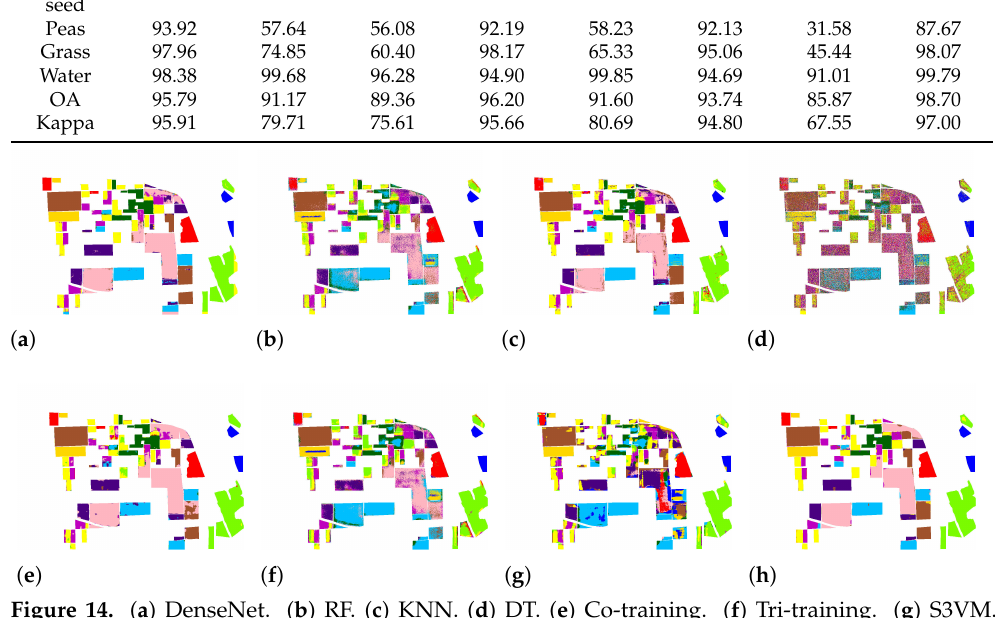
Figure 14. ( a ) DenseNet. ( b ) RF. ( c ) KNN. ( d ) DT. ( e ) Co-training. ( f ) Tri-training. ( g ) S3VM.